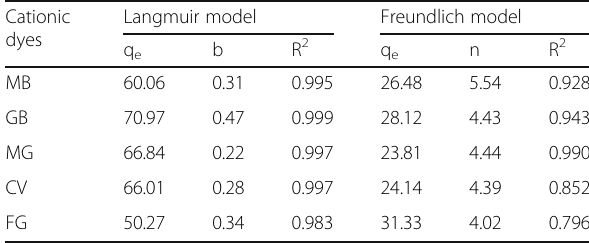
Table 2 Parameters of adsorption isotherm models parameters for the adsorption of dyes on Fe 3 O 4 /PCC MNPs Cationic Langmuir model dyes